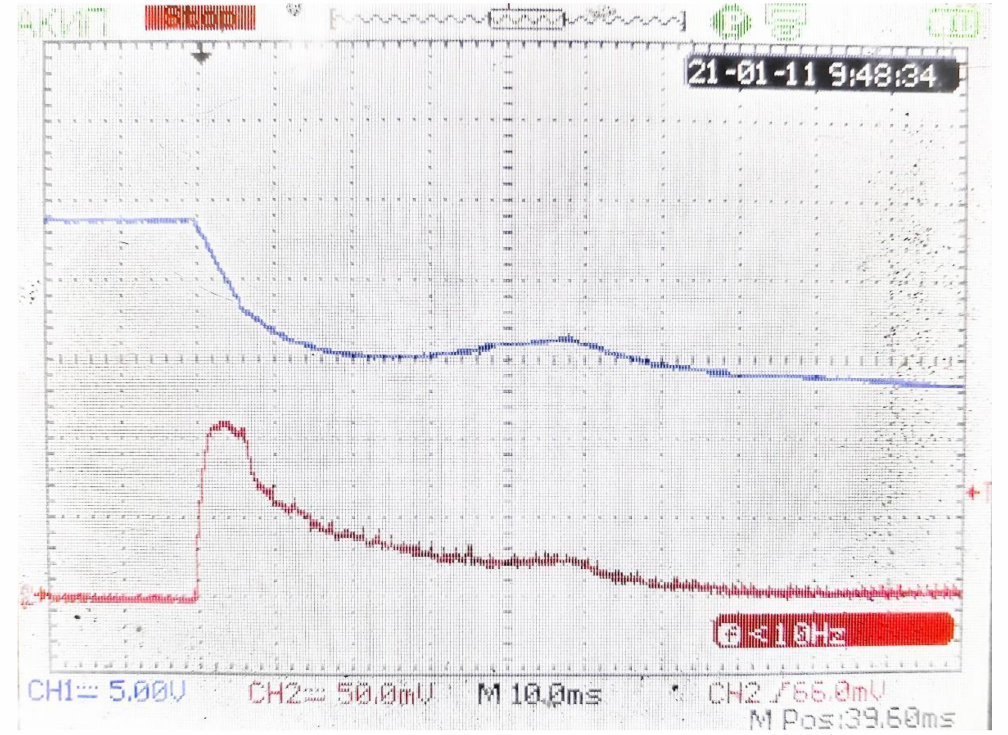
Figure 14. Updated graph of the current